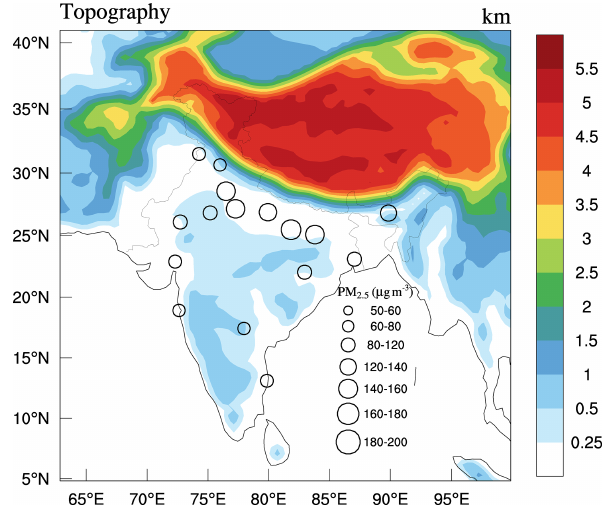
Figure 1. Study domain centred over South Asia. Colour map shows the topography (km), and circles indicate the near-surface mass loading (µgm − 3 ) of particles below the 2.5µm size range (PM 2 . 5 ). PM 2 . 5 data are taken from the Central Pollution Control Board (CPCB),